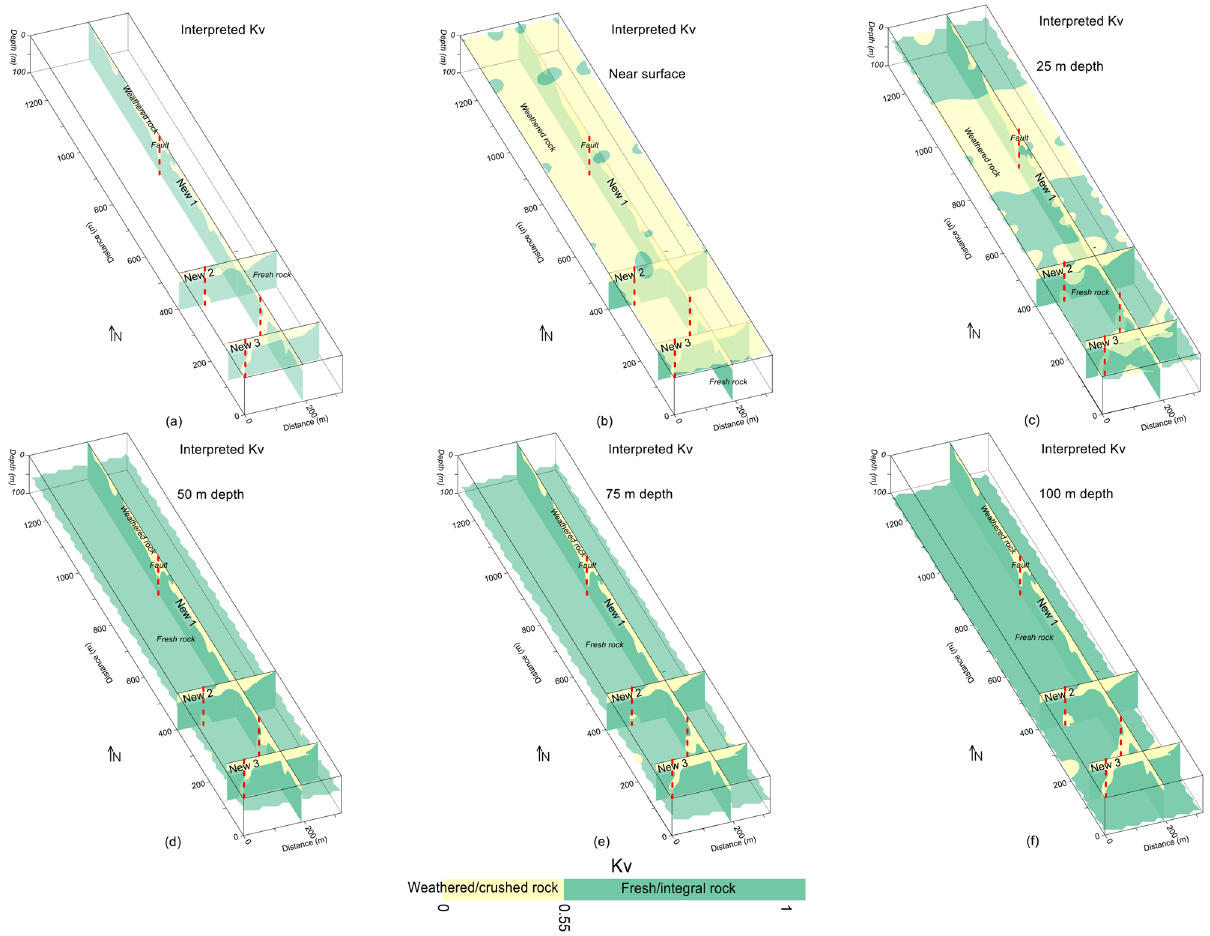
Figure 11. Kv imaging interpreted by crushed/weathered rock (yellow color), integral/fresh rock (green color) and faults (dashed red lines) for: ( a ) the integration of three Kv profiles, ( b ) ground surface including ( a ); ( c ) 25 m depth including ( a ); ( d ) 50 m depth including ( a ); ( e ) 75 m depth including ( a ); and ( f ) 100 m depth (bottom) including ( a